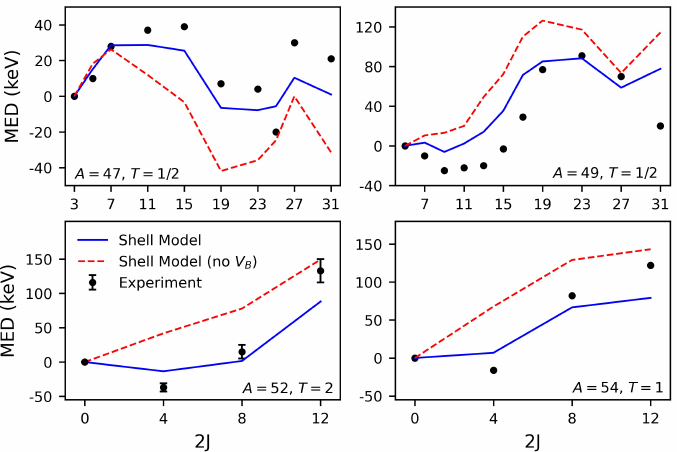
Figure 4. Experimental and shell-model MED in the f 7 shell. The solid blue lines contain the full 2 shell-model calculation, including a single isovector J = 0 INC matrix element of V B = − 79 keV. See text for details. The red dashed lines show the calculations without V B included. Data for “Shell Model (no V B )” originally presented in Ref. [17]. Where error bars are not visible, they are smaller than the data